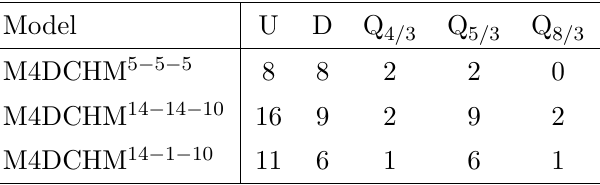
that have exotic electric charge x . x